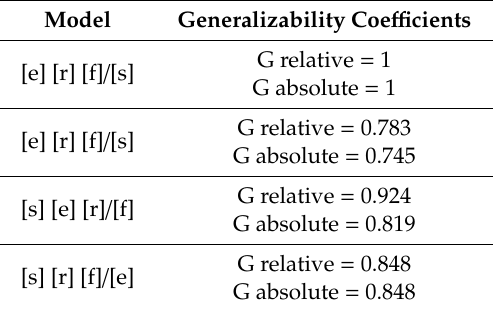
Table 7. Absolute generalizability coe ffi cient and relative generalizability coe ffi cient for [e] [r] [f] / [s] model and its di ff erent